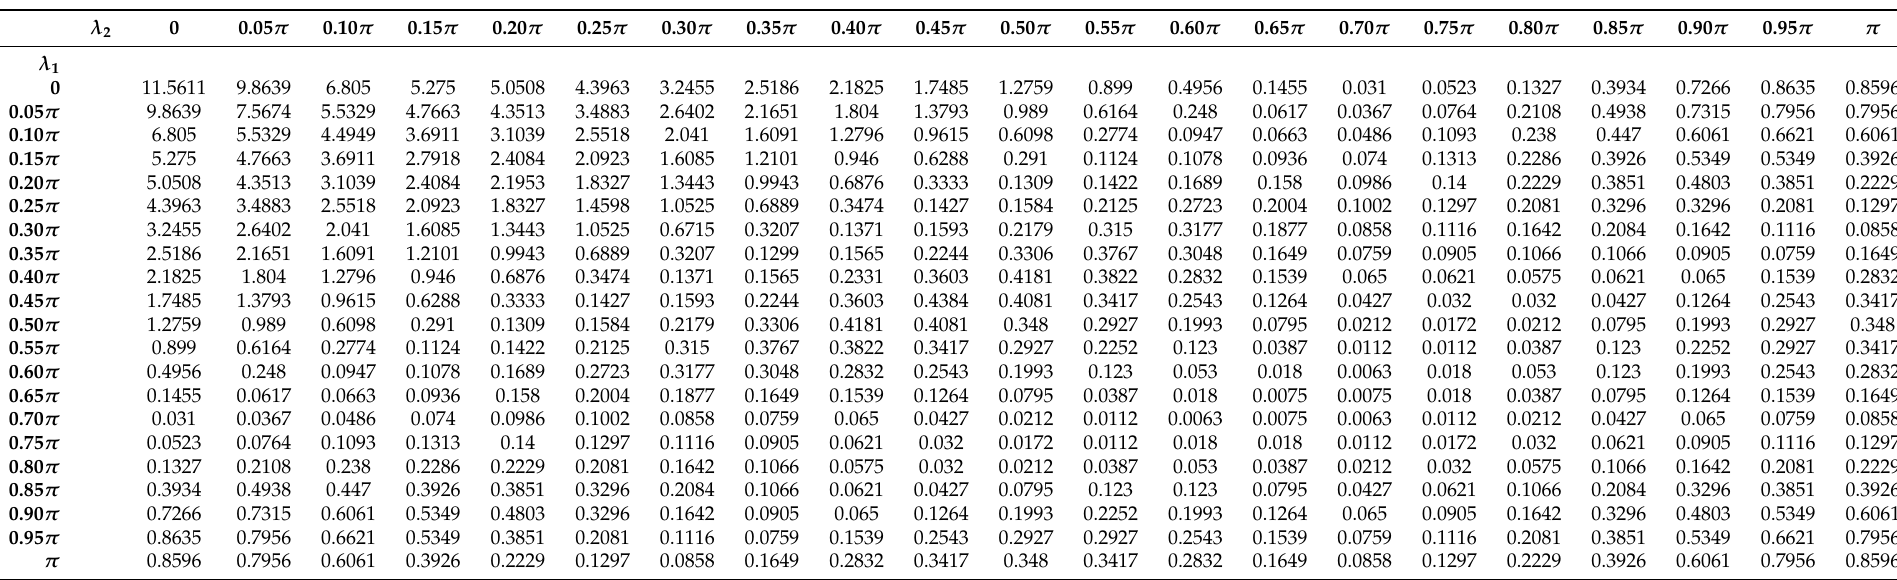
Table 2. Numerical values of smoothed multitapered biperiodogram of DCGINAR(1) model with M = 12 and β =